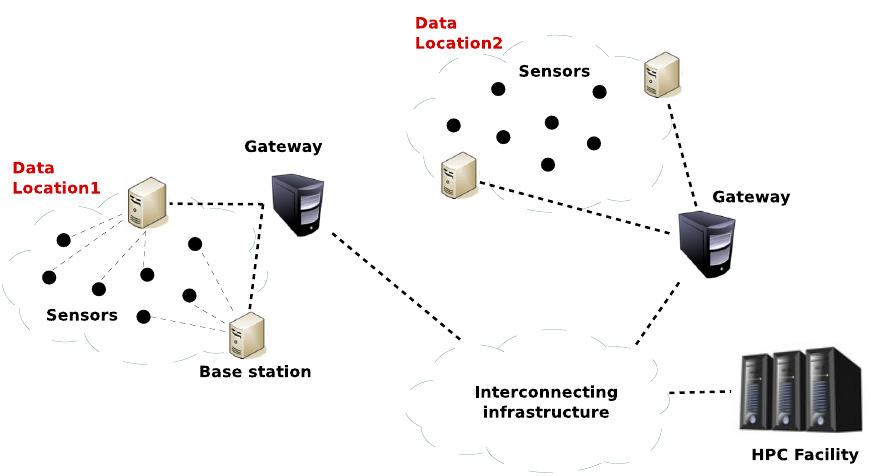
Figure 4. Proposed network